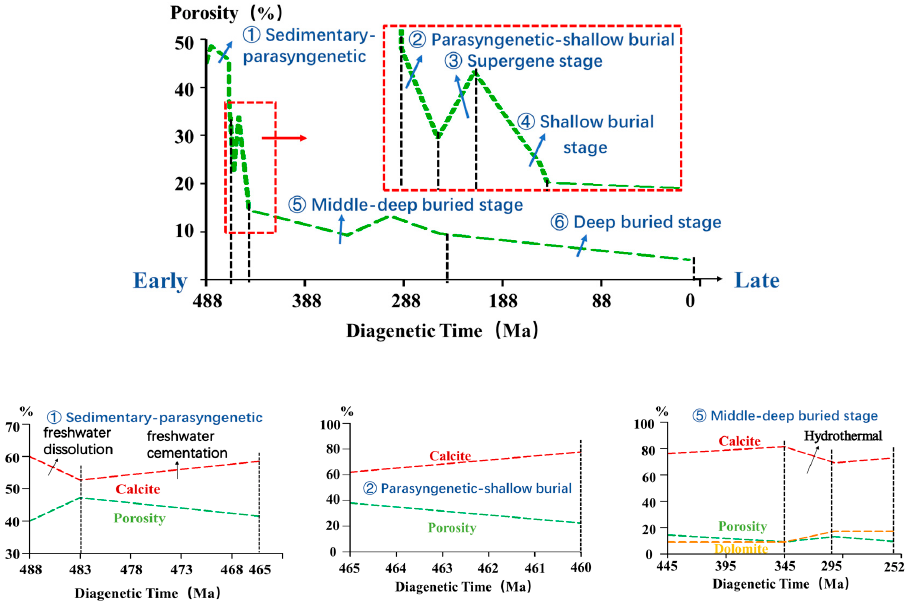
Figure 9. Porosity and typical mineral content evolution under meteoric fresh water and freshwater phreatic environment.